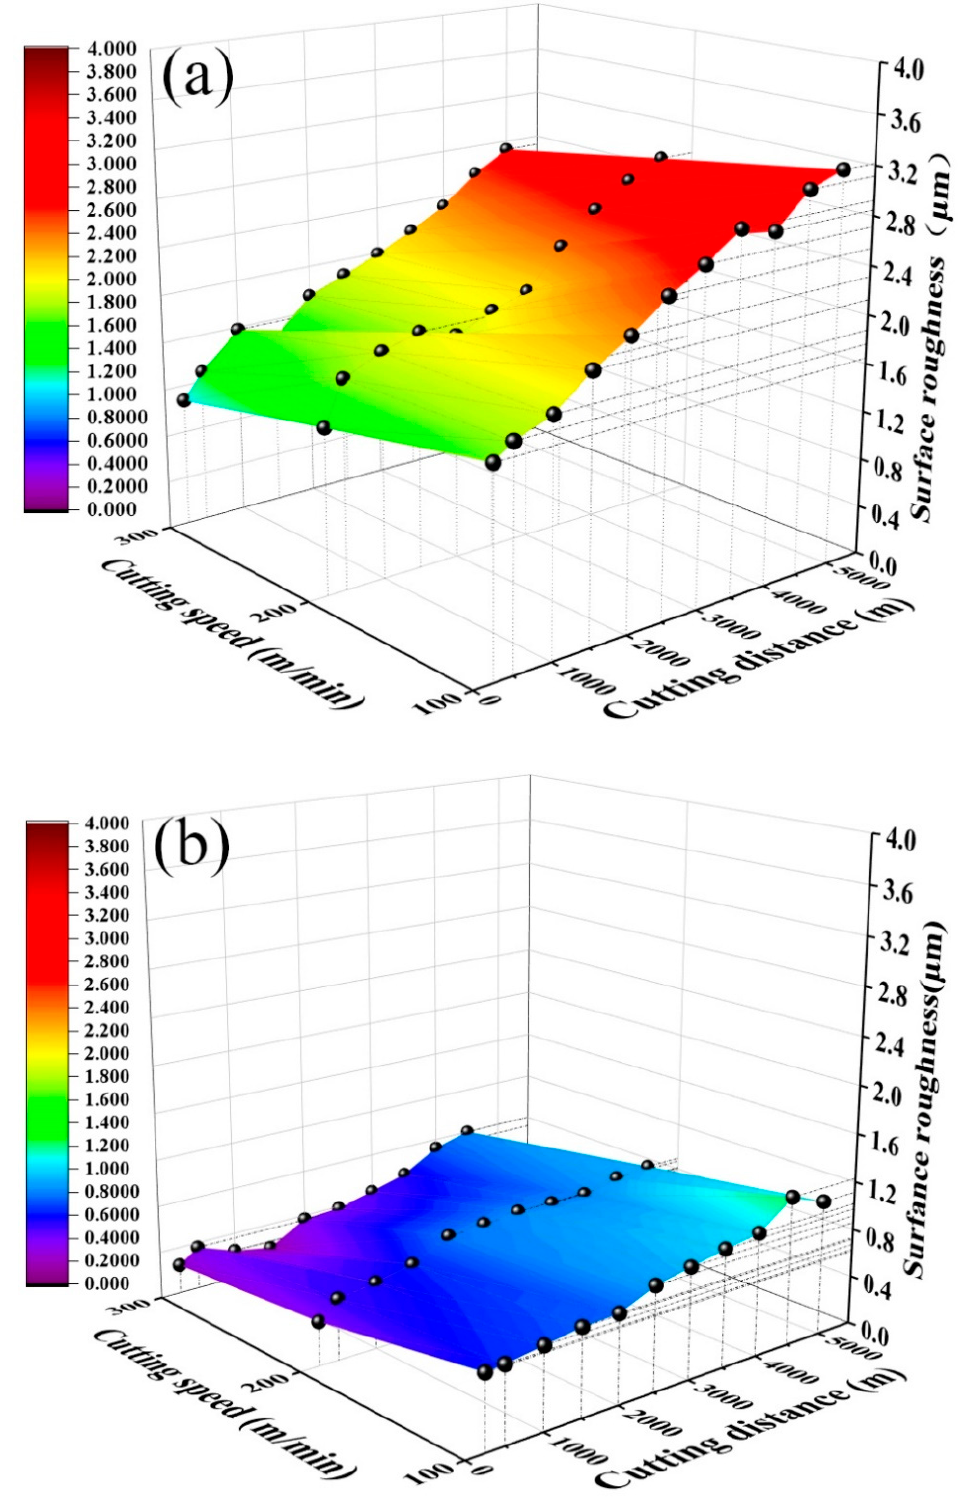
Figure 5. Workpiece surface roughness R a against cutting distance S at different cutting speeds: ( a ) ATS, ( b ) ATSC10.